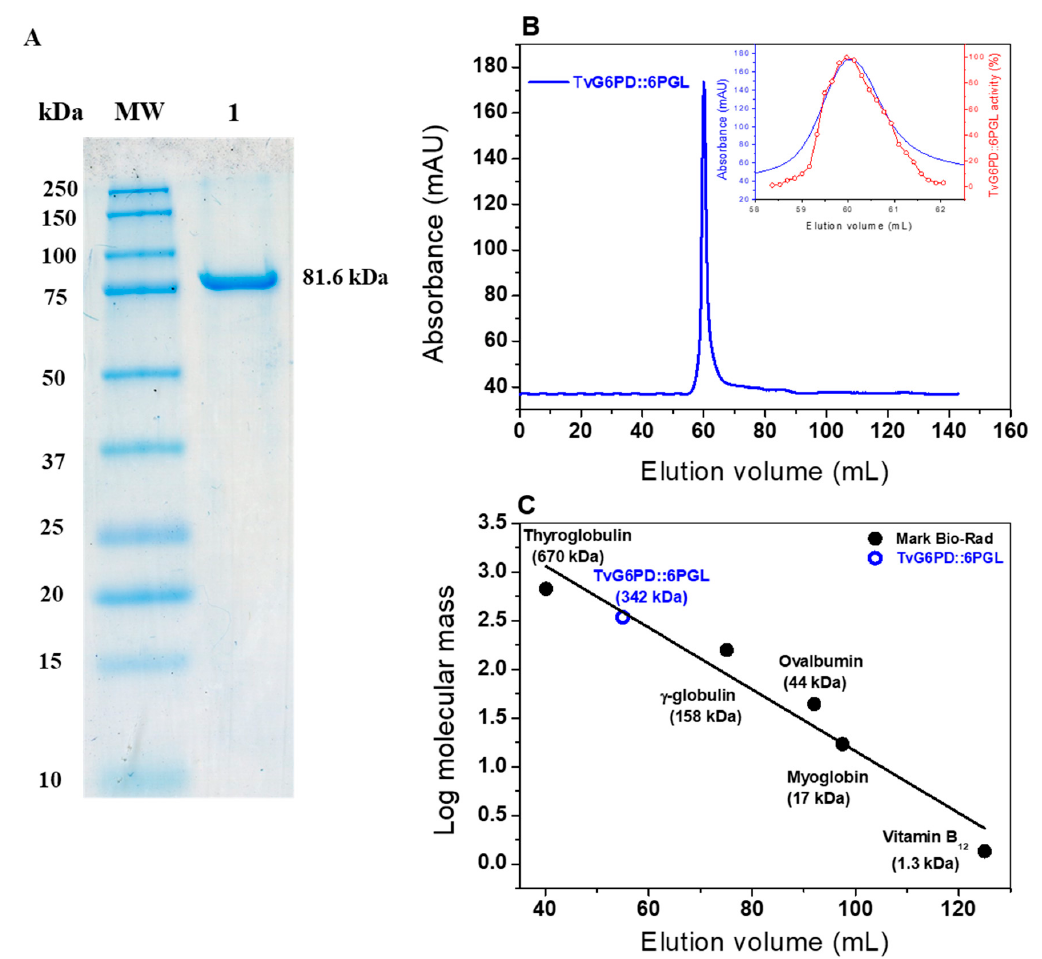
Figure 3. Purification and native status of the TvG6PD::6PGL protein. ( A ) Polyacrylamide gel electrophoresis SDS-PAGE (12%) of the recombinant TvG6PD::6PGL protein. M: Protein molecular weight (MW) marker precision plus protein kaleidoscope standards from Bio-Rad (Bio-Rad, Hercules, CA, USA). Lane 1. TvG6PD::6PGL purified protein (10 µ g). ( B ). Size exclusion chromatography of TvG6PD::6PGL. Inset: Blue line indicates the TvG6PD::6PGL purified protein, and the red line represents the TvG6PD::6PGL activity. ( C ) Calibration curve showing the elution volumes versus the log of the molecular weight (MW) of the Bio-Rad gel filtration standard ( • ). MW of the TvG6PD::6PGL protein ( •